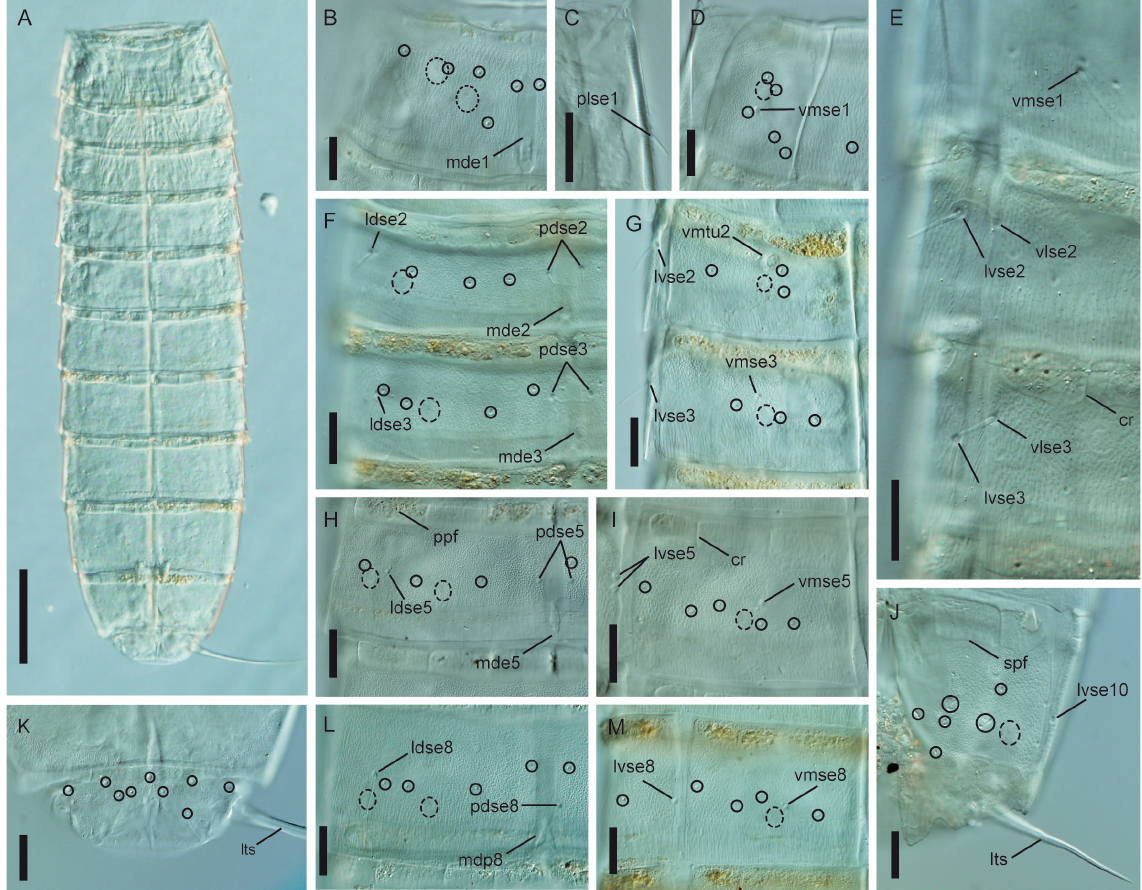
N eck . With four dorsal and two ventral sclerotized placids (Fig. 2A–B). Dorsal placids rectangular, with a slightly convex anterior margin; mesial ones broader (ca 31–33 µm wide at base) than lateral ones (ca 28–30 µm wide at base) (Fig. 2B). Ventral placids (ca 22–23 µm wide at base) morphologically similar to dorsal ones but much more elongated, getting thinner towards lateral sides (Fig. 2A, C).